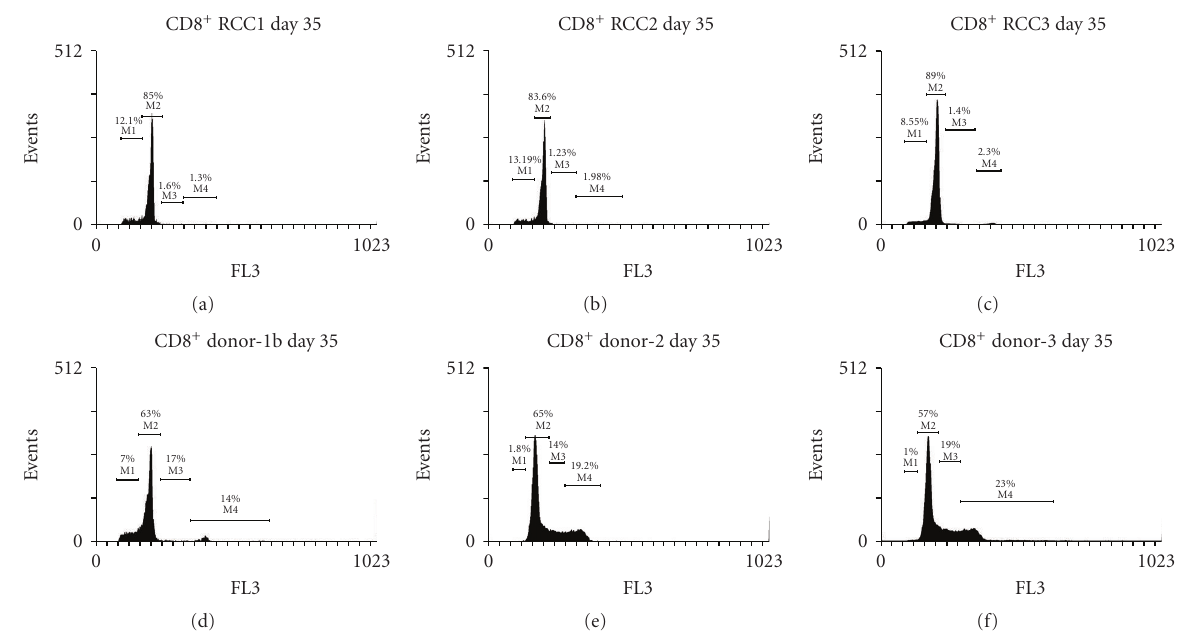
Figure 5: Cell cycle analysis of responder-CD8 + T cells after MLTC . Cellular DNA content was analyzed in three RCC patients and their HLA-matched normal donors by flow cytometry, with data analyzed on WinMDI version 2.8 software.